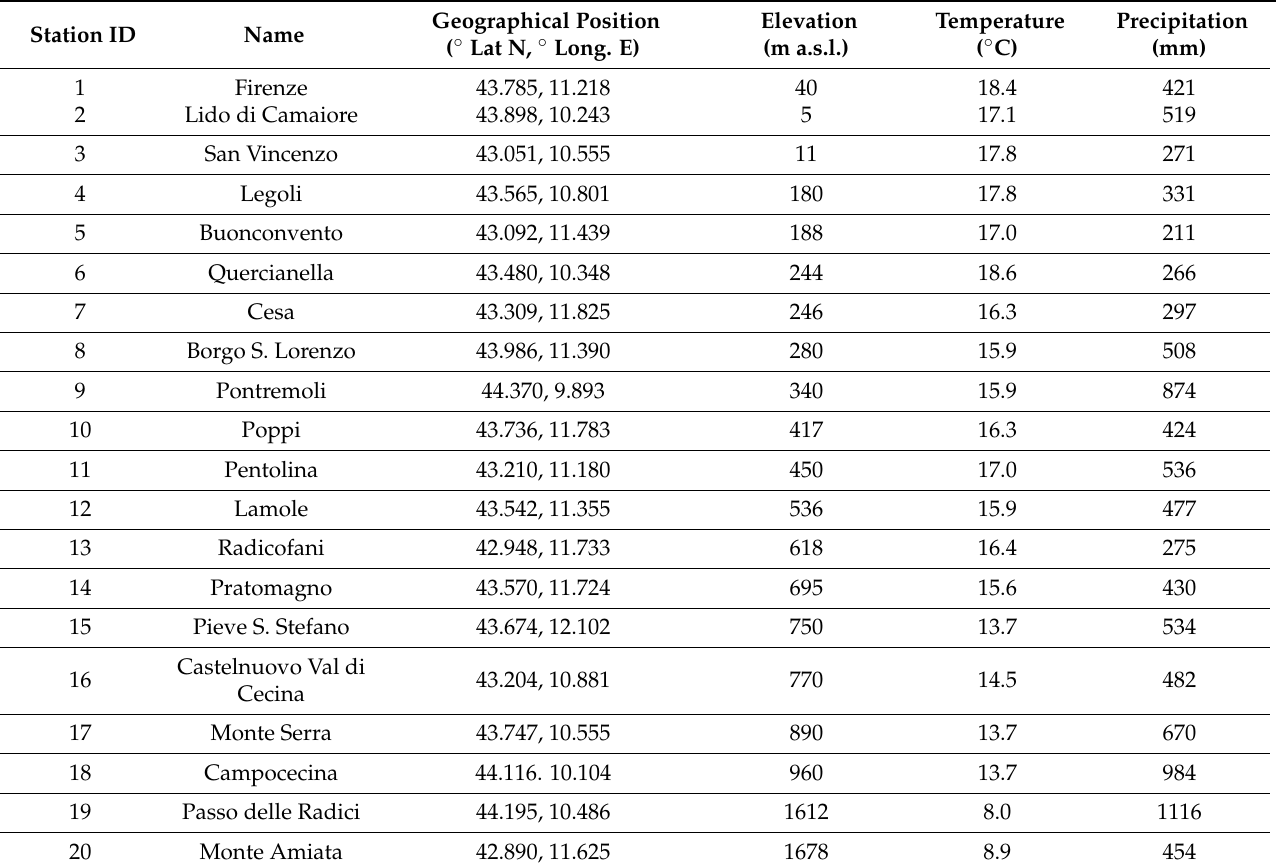
Table 1. Main features of the 20 selected ground weather stations. Mean air temperature and total precipitation refer to the investigated study period, i.e., March–November